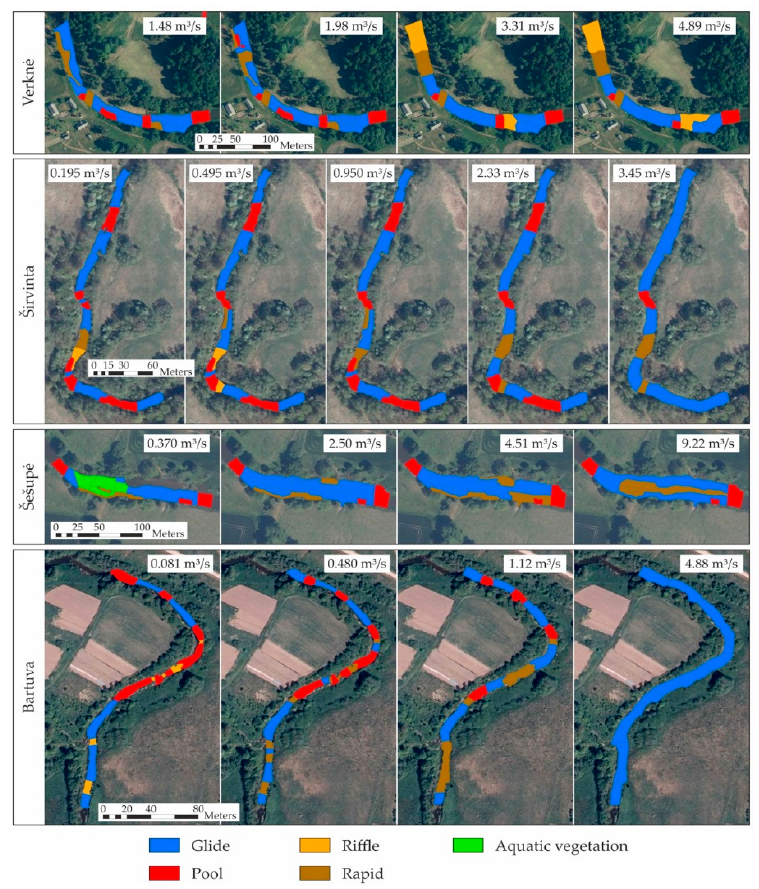
Figure 3. The results of HMUs mapping and their changes depend on the four discharges of the warm period for the Verkn ė , Šešup ė and Bartuva rivers, and five discharges for the Širvinta River. Despite the obtained changes in HMUs composition with the respect to the different discharge conditions, the alterations in the hydraulic features (river depth and flow